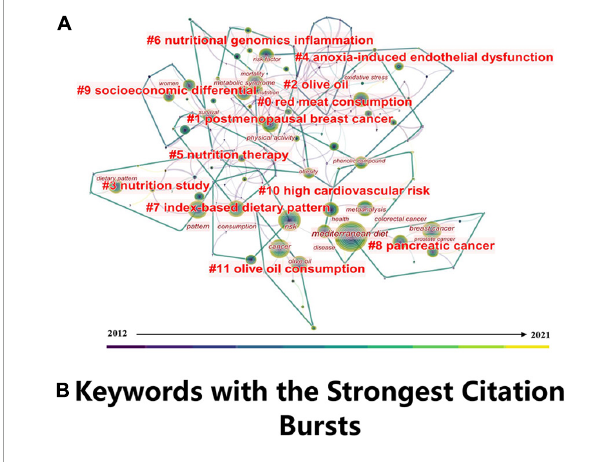
FIGURE8 (A) Cluster and collaboration map of keywords. (B) Bursts detection map of keywords.